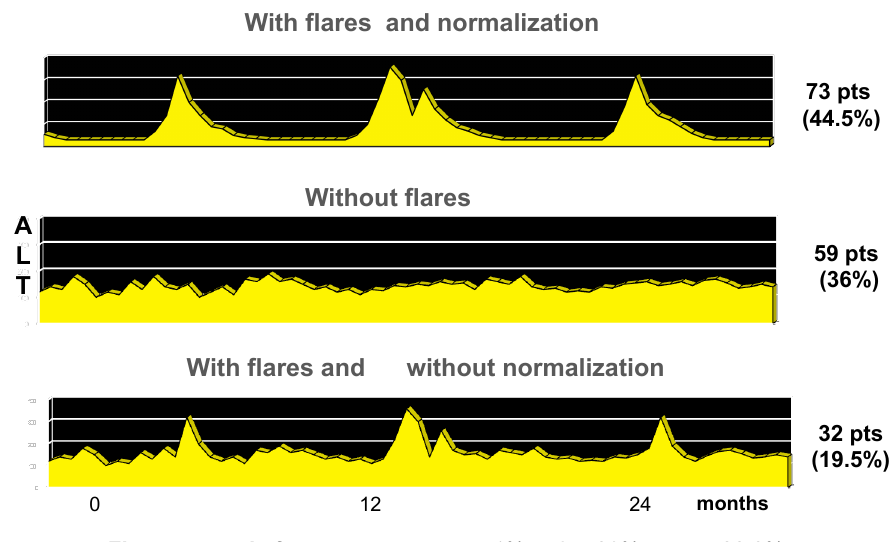
Figure 4. The natural course of HBeAg-negative CHB is characterized by different ALT patterns: hep- atitis reactivations (mostly asymptomatic) intervened by long-lasting periods where the transaminase levels are normal, persistent mild to moderate ALT elevation, or persistent mild ALT elevation with superimposed occasional hepatitis exacerbation with highly elevated ALT (>500 IU/dL)